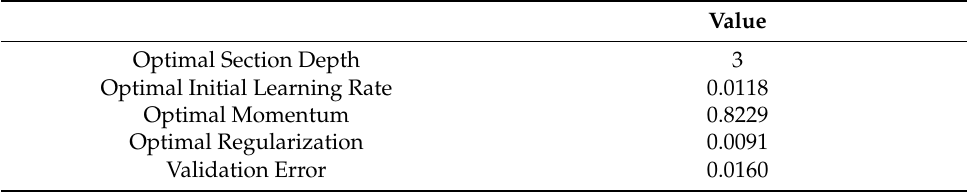
Table 6. Optimal CNN parameters values using BA (first version).